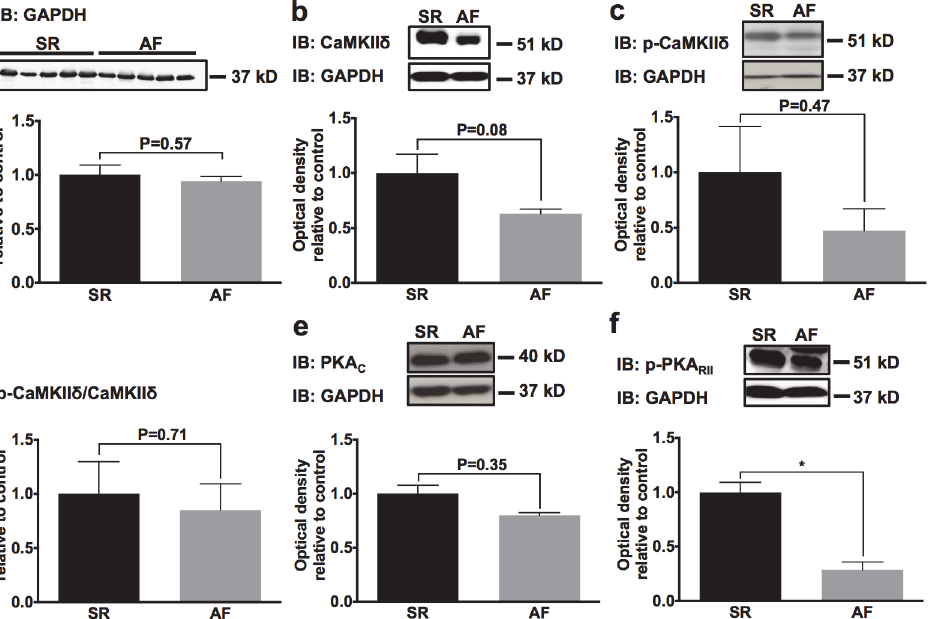
Fig 2. AF-induced remodeling of Ca 2+ -calmodulin-dependent protein kinase II (CaMKII) δ and protein kinase A (PKA). Representative Western blots and mean optical density values normalized to glyceraldehyde 3-phosphate dehydrogenase (GAPDH) are displayed relative to sinus rhythm (SR) controls. a, Absolute expression levels of the reference protein, GAPDH, were note affected by AF. b, c Normalized protein expression of total CaMKII δ and phosphorylated CaMKII δ (Thr286) in AF animals compared to SR. d Relative CaMKII δ autophosphorylation at Thr286 was not different between animal groups. e, f Protein levels of catalytic PKA C α / β subunits (PKA C ) and of phosphorylated regulatory RII α subunits (PKA RII ) in AF and SR animals. Mean values obtained from five animals per group are provided ± SEM; * P < 0.05.